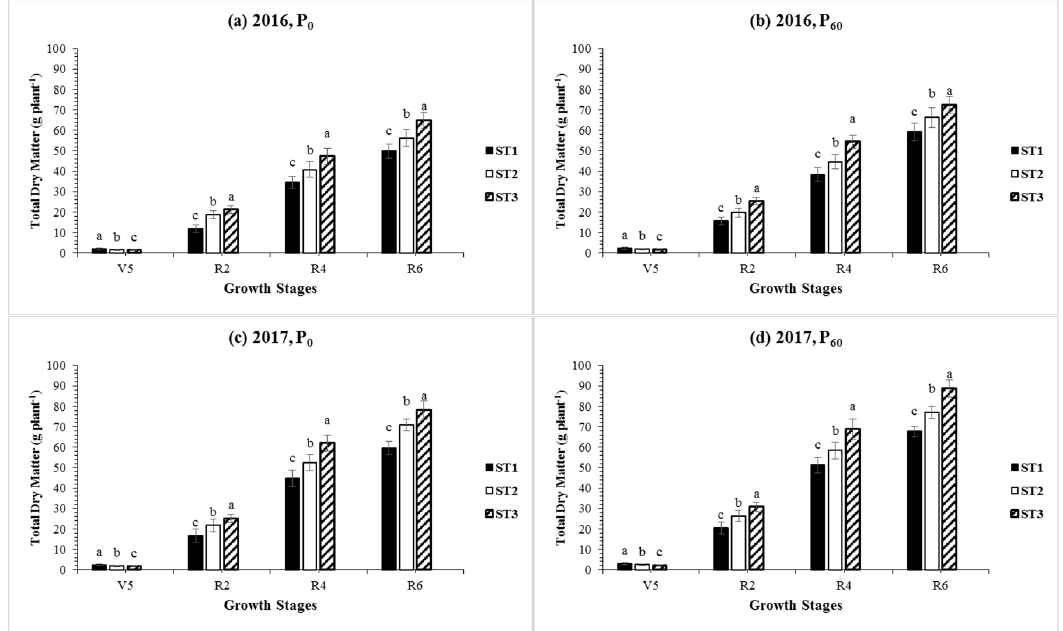
Figure. 2. Total above ‐ ground dry matter of relay intercrop soybean as affected by three different sowing times at two rates of phosphorus fertilizer (P 0 ; A and C , and P 60 ; B and D ) during the cropping seasons of 2016 and 2017. ST 1 , ST 2 , and ST 3 represents the sowing times 15–20 May (90 days of co ‐ growth period in maize soybean relay intercropping system (MSICS)), 5–10 June (70 days of co ‐ growth period in maize soybean relay intercropping system (MSICS)), and 25–30 June, (50 days of co ‐ growth period in maize soybean relay intercropping system (MSICS)), respectively. V 5 , R 2 , R 4 , and R 6, refer to five trifoliate, full flowering, full pod, and full seed phenological stages of soybean. The P 0 and P 60 refer to 0 and 60 kg phosphorus ha ‐ 1 , respectively. Means are averaged over three replicates. Bars indicate ± standard errors, ( n = 3). Between bars in groups, different lowercase letters indicate a significant difference ( p < 0.05) between treatments.